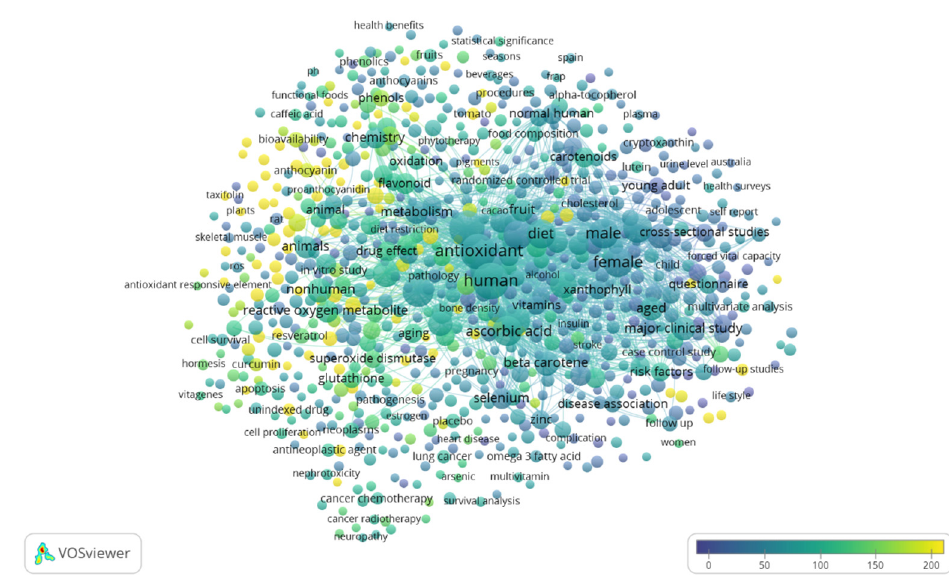
Figure 1. Term map for the relationship between dietary antioxidant and health research. Bubble size represents the number of publications. Bubble color represents the citations per publication (CPP). Two bubbles are closer to each other if the terms co-appeared more frequently (bibliometric data were extracted from the Scopus online database and elaborated by the VOSviewer software).